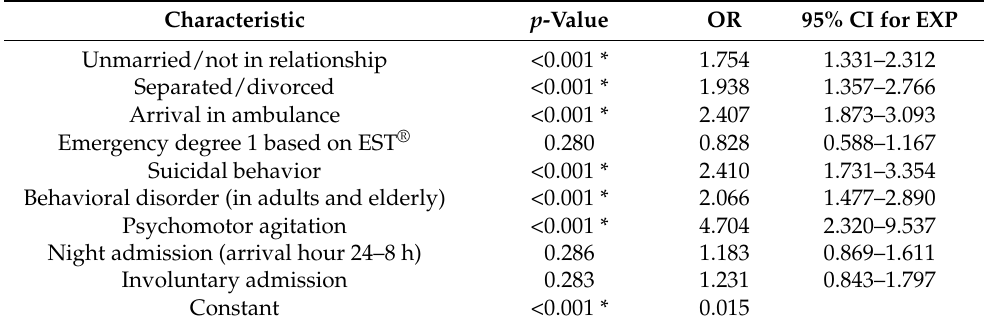
Table 2. Logistic regression analysis of the relationships between potential explanatory variables and psychiatric ED admissions in the “during-pandemic” sample.